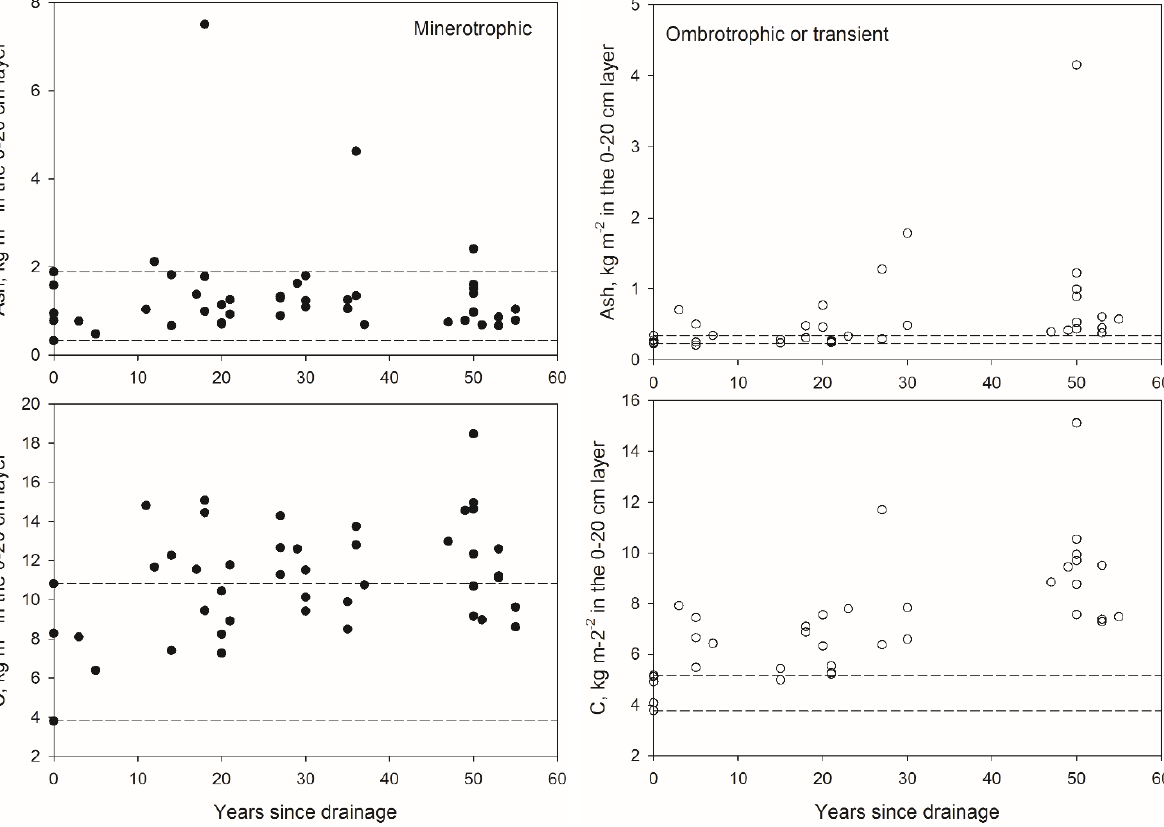
Figure 7. Ash (upper panels) and carbon (C) (lower panels) contents (kg m -2 ) in the topmost 0–20 cm peat layer, in ‘minerotrophic’ (left) and ‘ombrotrophic and transient’ (right) sites sampled by Laiho & Laine (1994, 1995). Sites as in Figure 1. Note that the y-axis scales differ between the site type groups. Dashed lines indicate the range of values in the undrained